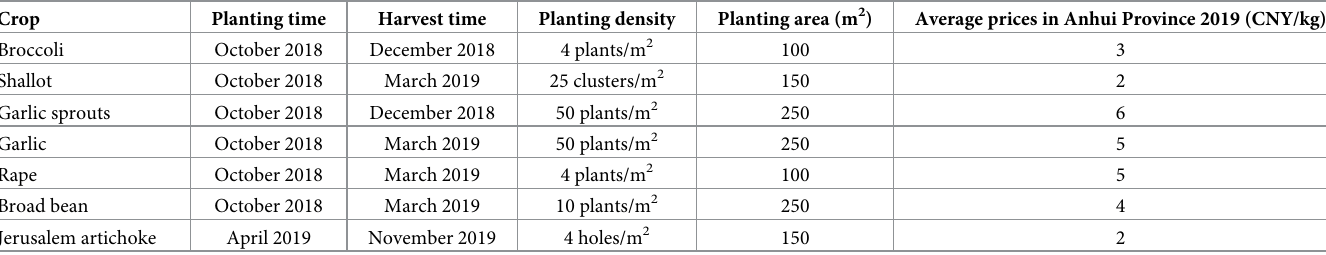
Table 1. The cultivation information and average prices of crops in the large-scale field planting experiment. Crop Planting